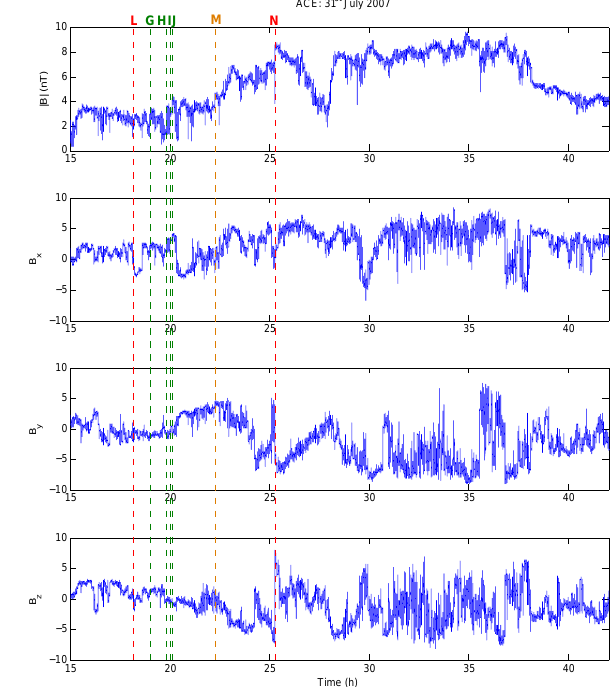
Fig. 3. Magnetic field data recorded by VEX during the CME cross- ing period on 30 July 2007. The vertical green dotted lines mark the shock crossing times (A:F) and the vertical orange dotted line (K) represent an example of a nonlinear structure that has not fully formed into a shock.